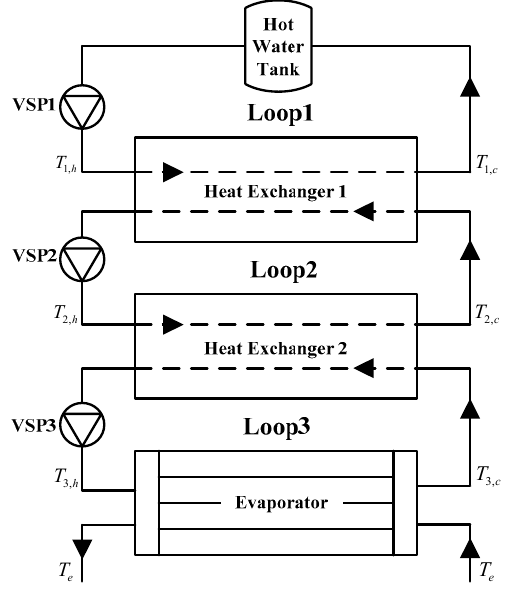
Figure 1. Sketch of a multi-loop heat transfer system [37].